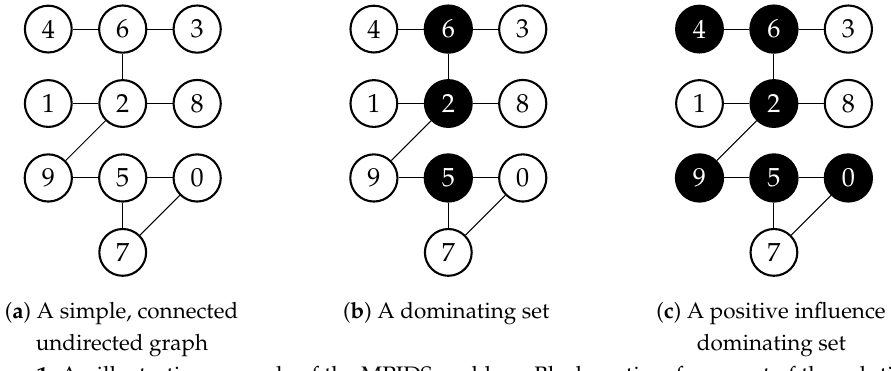
Figure 1. An illustrative example of the MPIDS problem. Black vertices form part of the